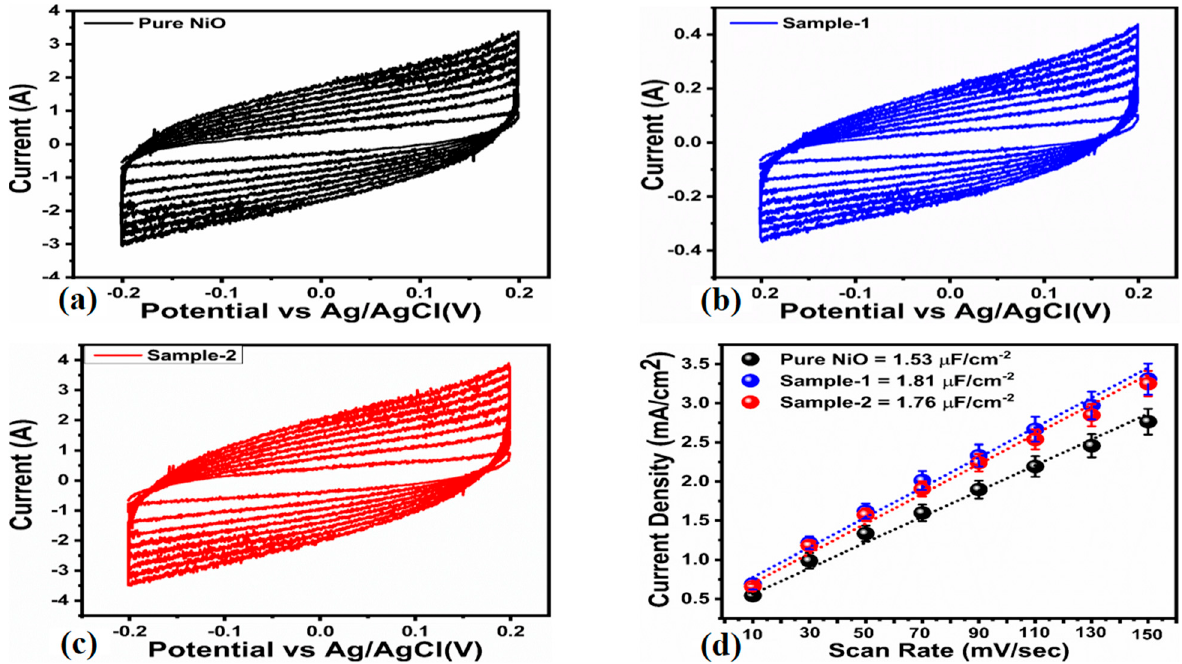
Figure 7. ( a – c ) CV curves measured at non-Faradic region at various scan rates such as 10, 30, 50, 70, 90, 110, 130, and 150 mV/s in 0.1 mM urea for pure NiO and sample 1 and sample 2, ( d ) linear plot of current density against di ff erent scan rates for the calculation of ECSA.